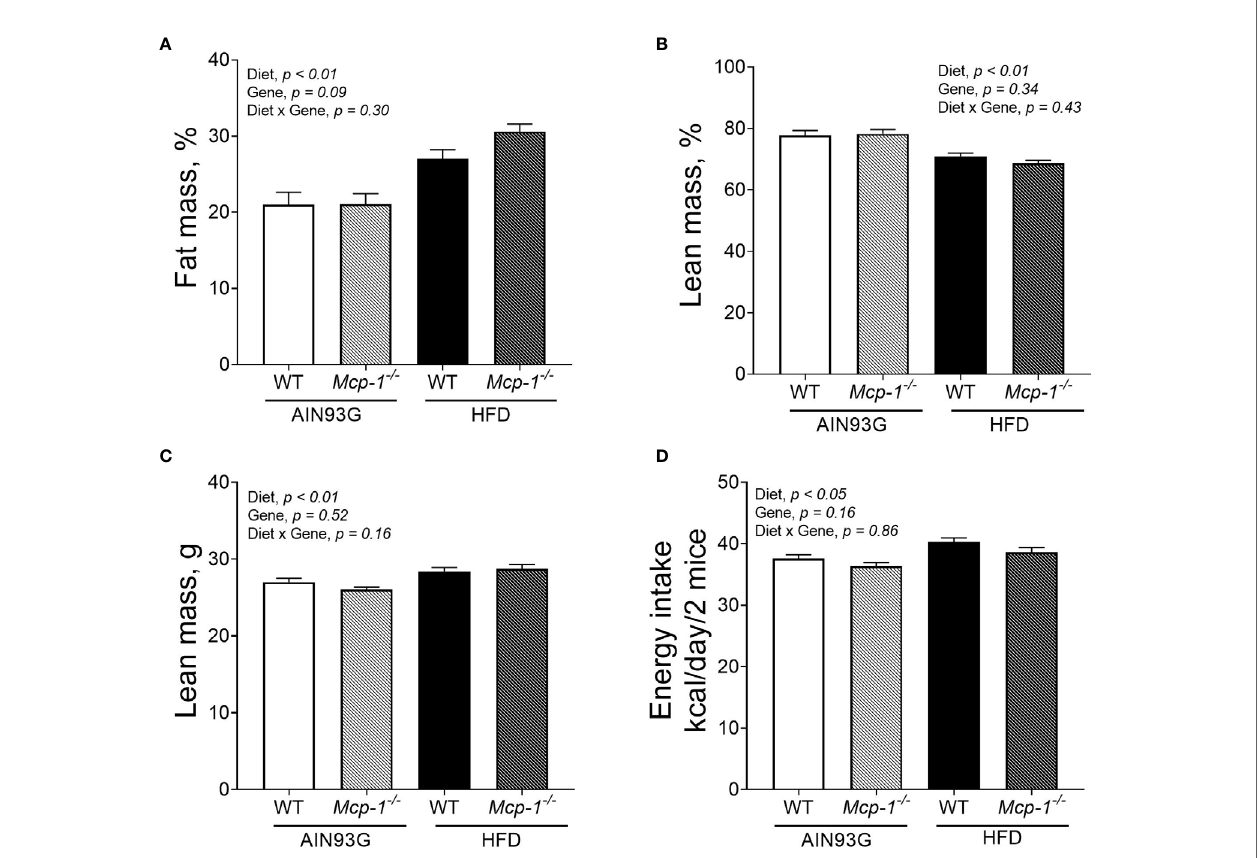
FIGURE 2 | The percent body fat mass (A) , percent body lean mass (B) , absolute lean mass (C) , and energy intake (D) of MMTV-PyMT mice with or without adipose monocyte chemotactic protein-1 knockout [ Mcp-1 -/- or wild-type (WT)] and fed the AIN93G or high-fat diet (HFD). Values are means ± SEM [n = 32 per group for WT mice, n = 34 per group for Mcp-1 -/- mice for (A – C) ; n = 12 mice per group for (D)